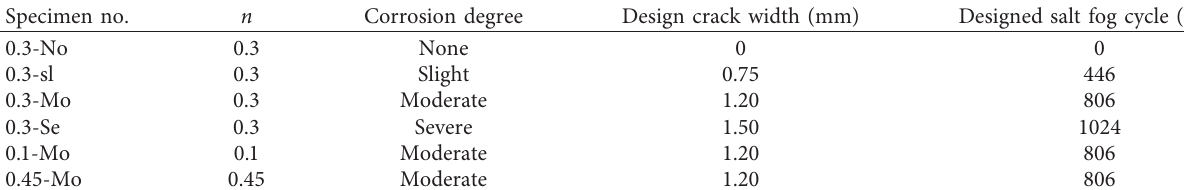
Table 1: Design parameters of specimens.